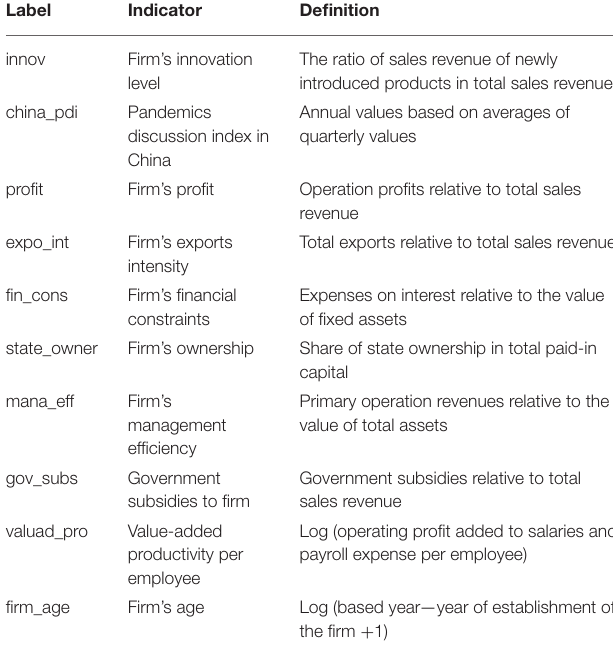
TABLE 1 | Labels and definitions of indicators in the